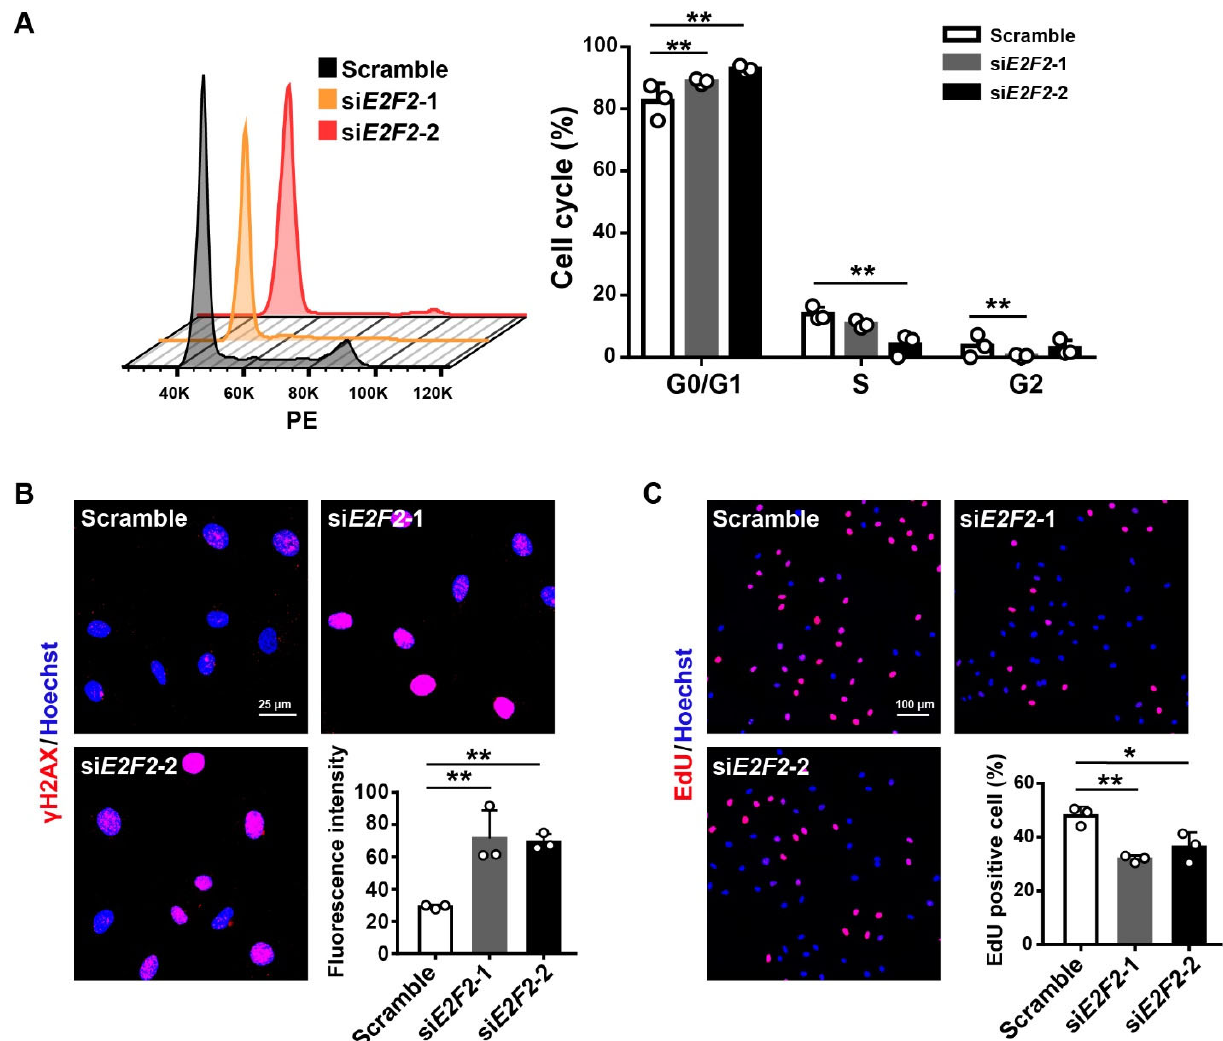
Figure 3. Impaired endothelial cell function in E2F2 ‐ knockdown HUVECs (PDL12). ( A ) Cell cycle analysis for HUVECs transfected with si E2F2s . Statistical analysis by two ‐ way ANOVA. ( B ) Immunofluorescent staining for the level of γ H2AX in E2F2 ‐ knockdown HUVECs. Scale bar: 25 μ m. Statistical comparison of mean fluorescent intensity using one ‐ way ANOVA. ( C ) EdU for the cell proliferation of E2F2 ‐ knockdown HUVECs. Scale bar: 100 μ m. One ‐ way ANOVA for a comparison of the percentage of EdU ‐ positive cells. Data are means ± S.D. * p < 0.05, ** p < 0.01.